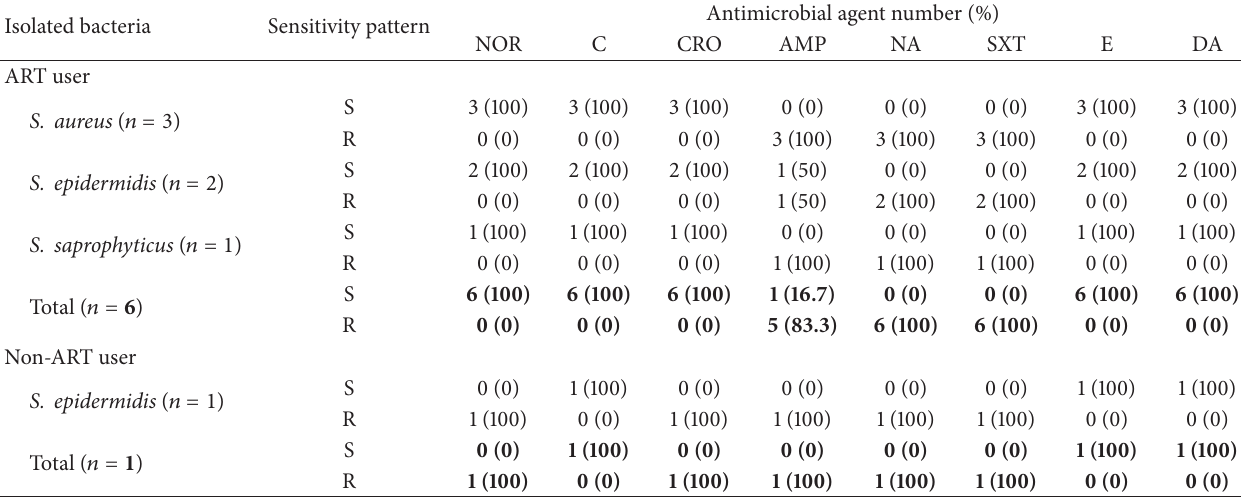
Table 6: Antimicrobial sensitivity pattern of Gram positive bacteria isolated from urine culture of ART and non-ART user patients, Jimma University Specialized Hospital, Ethiopia,